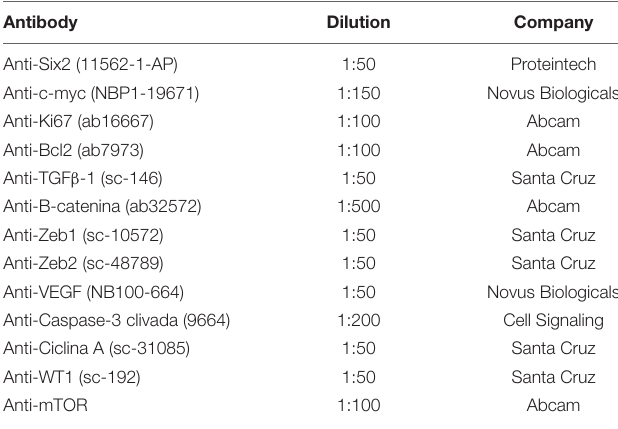
TABLE 1 | Dilution of antibodies used in